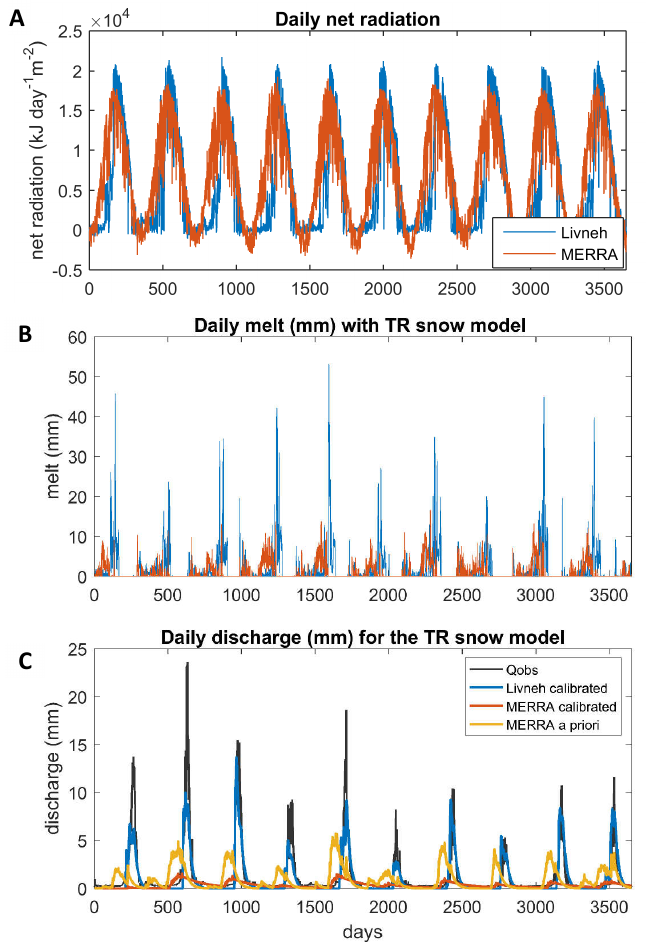
Figure 5. Daily net radiation for each forcing in catchment 06622700 (Panel A ). Daily snow melt (mm) for the enhanced temperature-based model (TR) estimated with both forcings using the SCE calibrated parameters (Panel B ). Observed and modelled discharge using SCE calibrated parameters for both forcings and the a priori (Ap) estimated parameters for the MERRA forcing (see Section 4.2) (Panel C